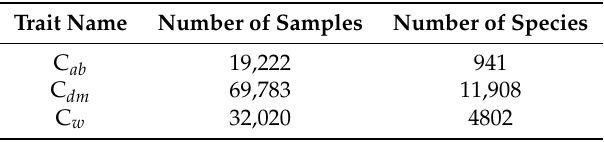
Table 2. Information about the TRY data used in this